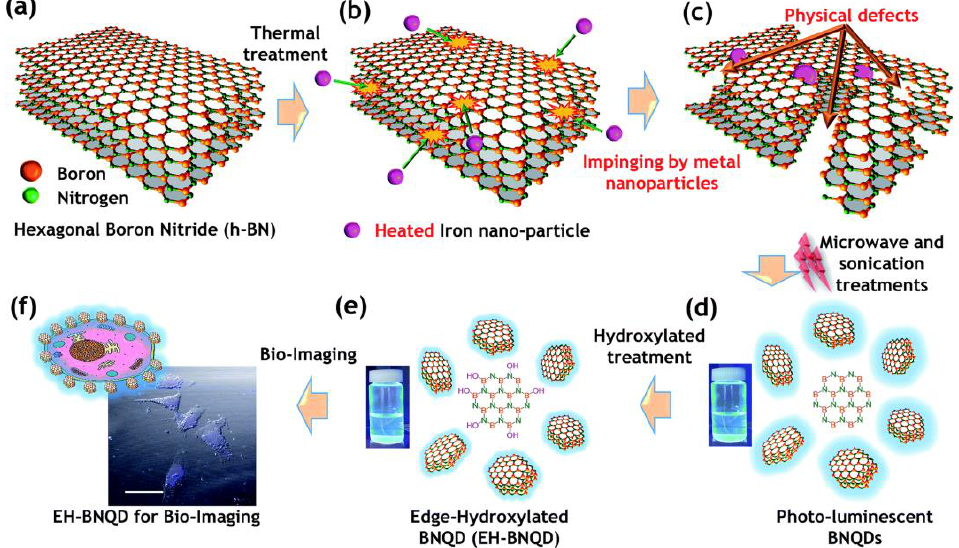
Figure 5. Defect engineering route to boron nitride quantum dots (BNQDs) and edge-hydroxylated BNQDs for bioimaging. ( a ) Hexagonal boron nitride, ( b ) impinging process of heated iron nanoparticles, ( c ) cracks and physical defects of h-BN, ( d ) BN QD after microwave radiation and sonication treatments, ( e ) edge-hydroxylated BN QD (EH-BN QD), and ( f ) EH-BN QD for bioimaging. Reproduced from [47] with permission from The Royal Society of Chemistry.